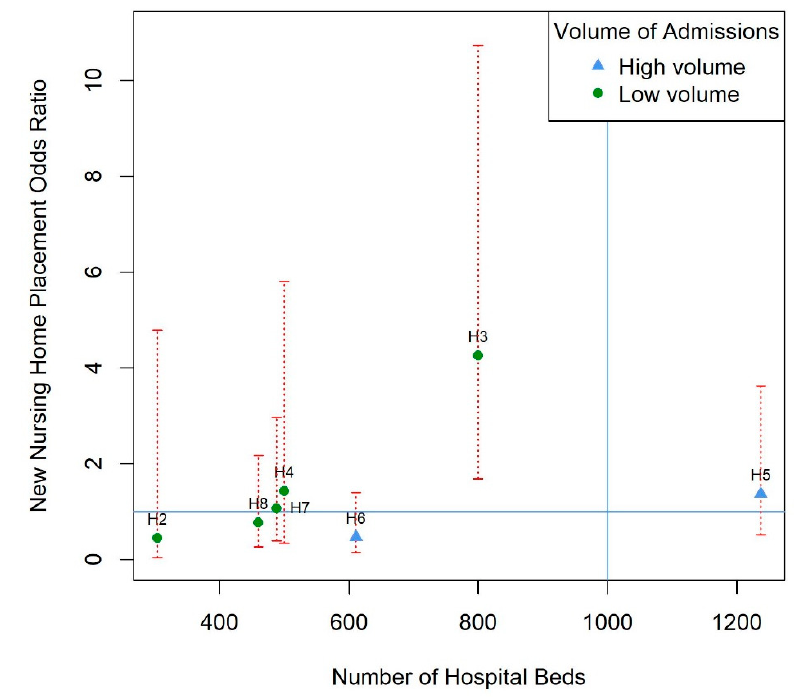
Figure 1. Model estimates of new nursing home placement odds ratio for each hospital against the size of the hospital (total number of hospital beds) and grouped by hospital stroke volume with 95% confidence intervals (red dotted lines). Volume is categorized into high (more than 50 admissions per month) and low (less than 50 admissions per month). Horizontal line represents an odds ratio of 1 for reference hospital 1. Vertical line represents the hospital size in hospital 1. This line is blue because the volume of stroke admissions is more than 50 admissions per month for this hospital. Multivariable regression model was adjusted for pre-stroke mRS score, discharge mRS score, total anterior circulation stroke (TACS), myocardial infarction or ischemic heart disease, complication, brain lateralization, and acute hospital length of stay, after multiple imputations for missing covariate data. H2–H8: hospital 2 to 8, consecutively.